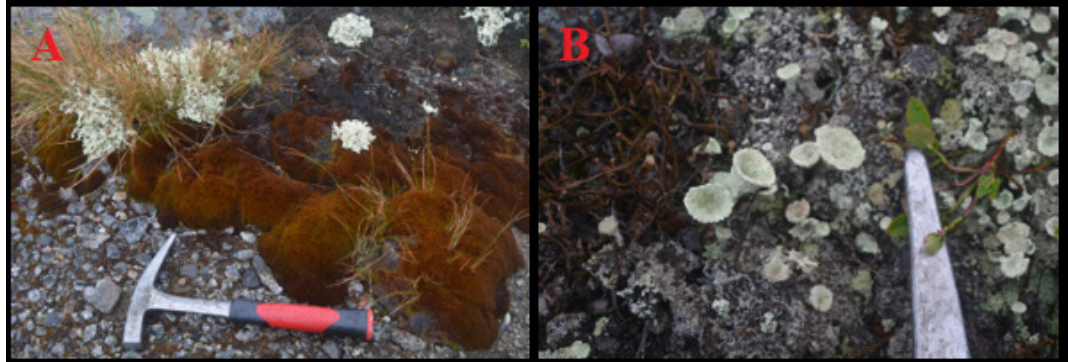
Figure 7. Examples of photographs of lichens from the study area: ( A )—lichens of cladonia sp. , in the